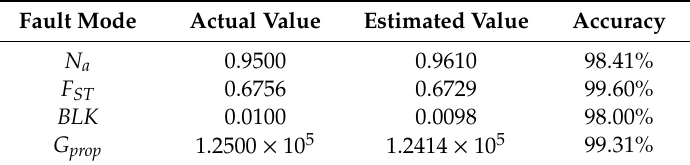
Table 5. FDI results for a random damage